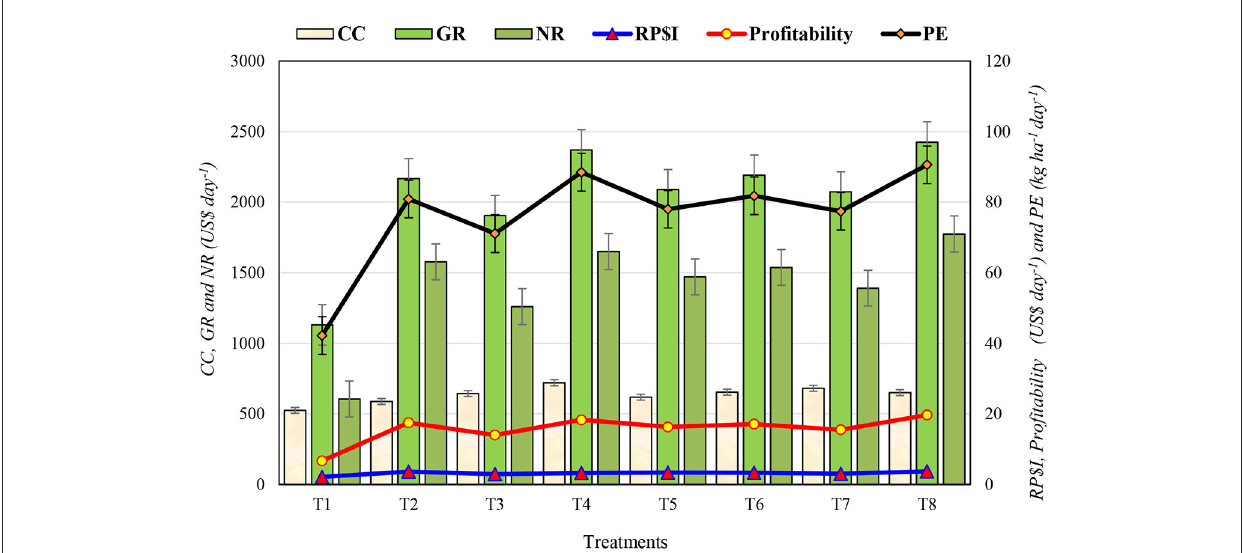
FIGURE2 Effect of the conjoint application of different organic sources of nutrients on profitability of French bean crop (2 years pooled mean value). CC, cost of cultivation; GR, gross return; NR, net return; RP$I, return per US$ invested; PE, production efficiency; T1—farmers’ practice (FYM ∼ 50% RDN); T2—100% RDN through FYM; T3—100% RDN through mixed compost (MC); T4—100% RDN through vermicompost (VC); T5—50% RDN through FYM + 50% RDN through MC; T6—50% RDN through FYM + 50% RDN through VC; T7—50% RDN through MC + 50% RDN through VC; T8—33% RDN through FYM + 33% RDN through MC + 33% RDN through